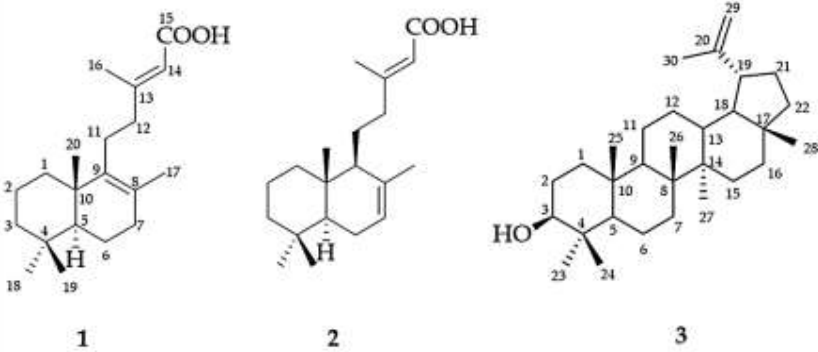
Figure 1. Chemical structures of three compounds isolated from T. grandis leaf extract.